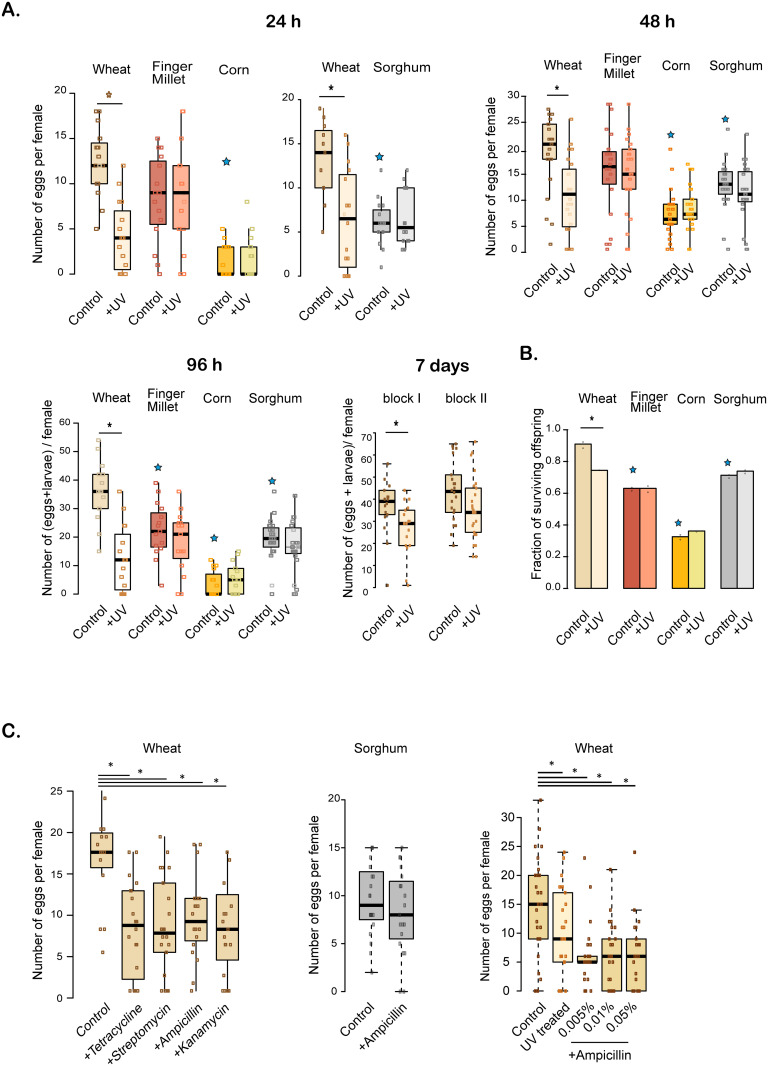
Impact of exposure to UV-treated or antibiotic-treated flour on fecundity and offspring survival.(A) Total fecundity (larvae+eggs) of females obtained from stocks and placed in untreated (“control”) vs. UV treated flour for 24 h, 48 h, 96 h or 7 d in wheat, or three novel resources (corn, finger millet, and sorghum). For the 24 h assay, sorghum was tested in an independent experimental block, with a separate wheat control; hence, it is shown as a separate figure. We included two independent experimental blocks for the 7d trial. (B) Offspring survival (average survival from eggs isolated in two 96-well plates per flour per treatment). (C) Total fecundity (larvae+eggs) of females obtained from stocks and placed in untreated (“control”) vs. antibiotic-treated flour (wheat or sorghum) for 48 hrs. In the first two panels, antibiotic concentrations are 0.005% w/w. Boxplots and raw data are as described in Fig 4; n = 25 females/treatment. Small black asterisks indicate a significant difference between control and treated resources; large coloured asterisks indicate a significant different between control for wheat vs. control for a novel resource. For statistical analysis, see S3 Table.